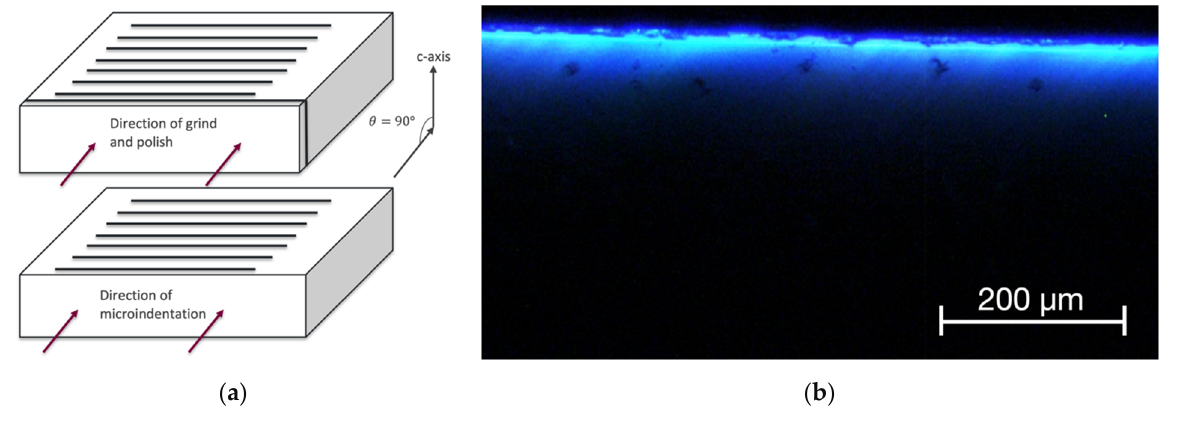
Figure 7. ( a ) A simplified diagram of the die structure to show grinding direction, viewing angle and indentation direction of Sample 3. ( b ) Optical microscopy image of Sample 3 after second-stage microindentation. Table 3. PV reading and intensity ratio of Samples 2 and 3.